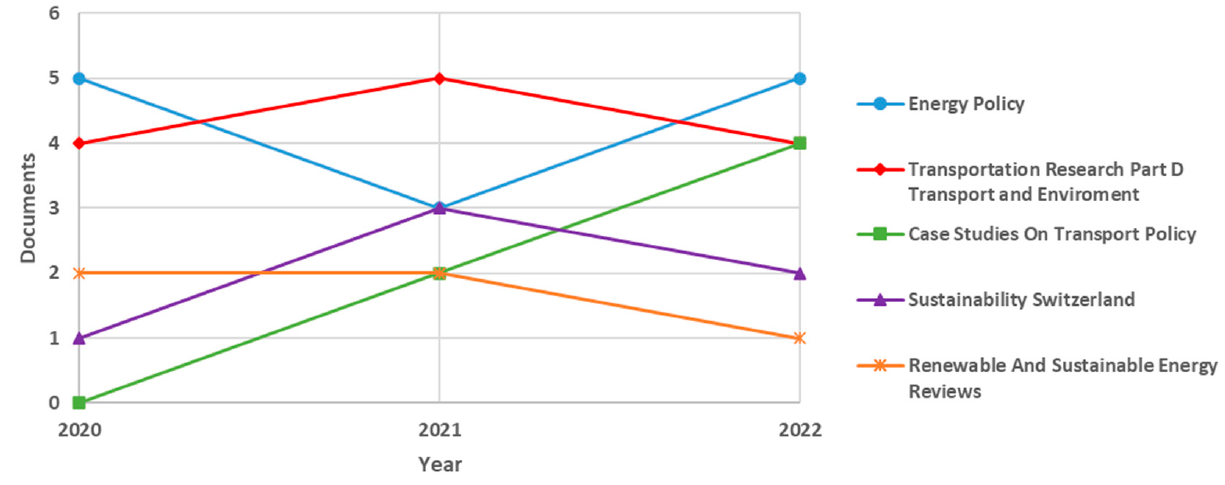
Figure 5 . Analyzed documents per year by source . Figure 5. Analyzed documents per year by